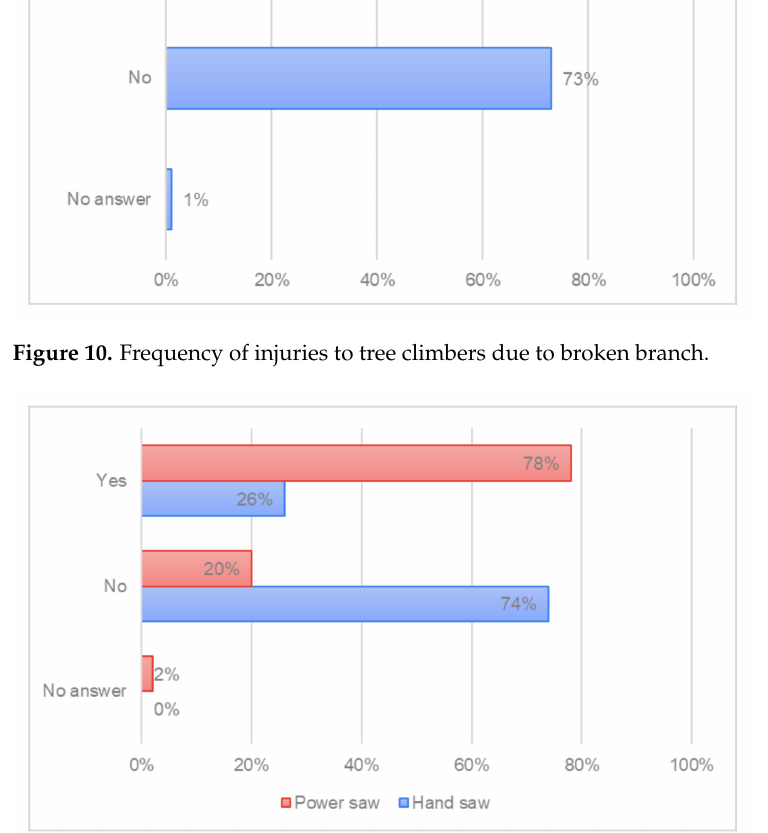
Figure 11. Comparison of the frequency of injuries by the power saw and hand